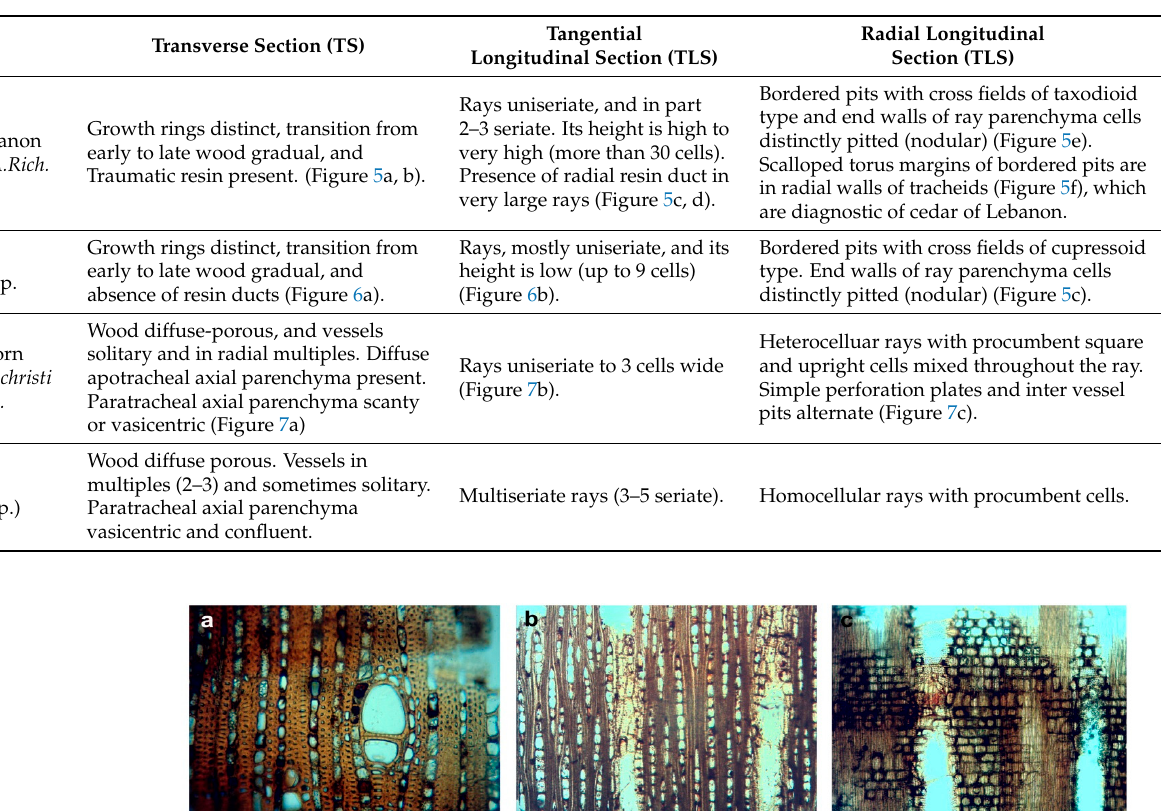
Table 4. Anatomical characteristics used for wood identification.